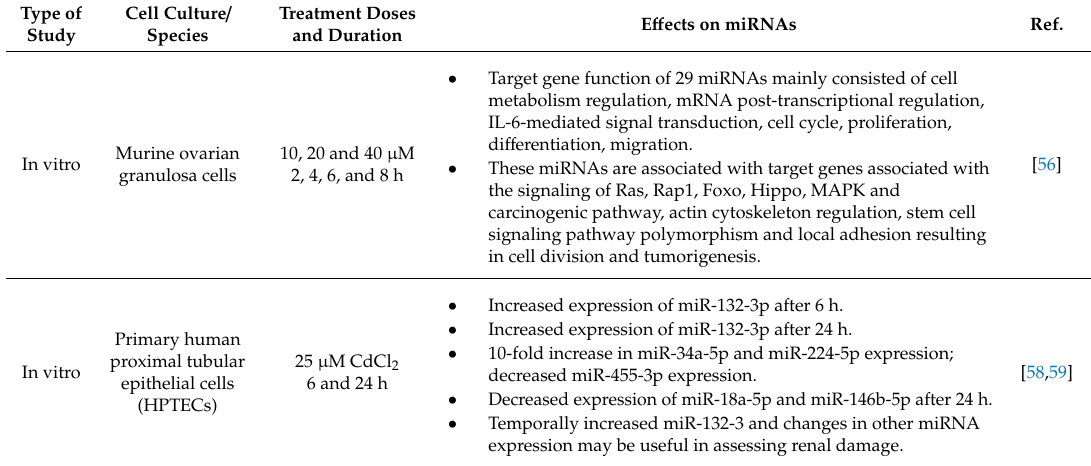
Table 1. Summary of studies analyzing e ff ects of Cd on microRNAs